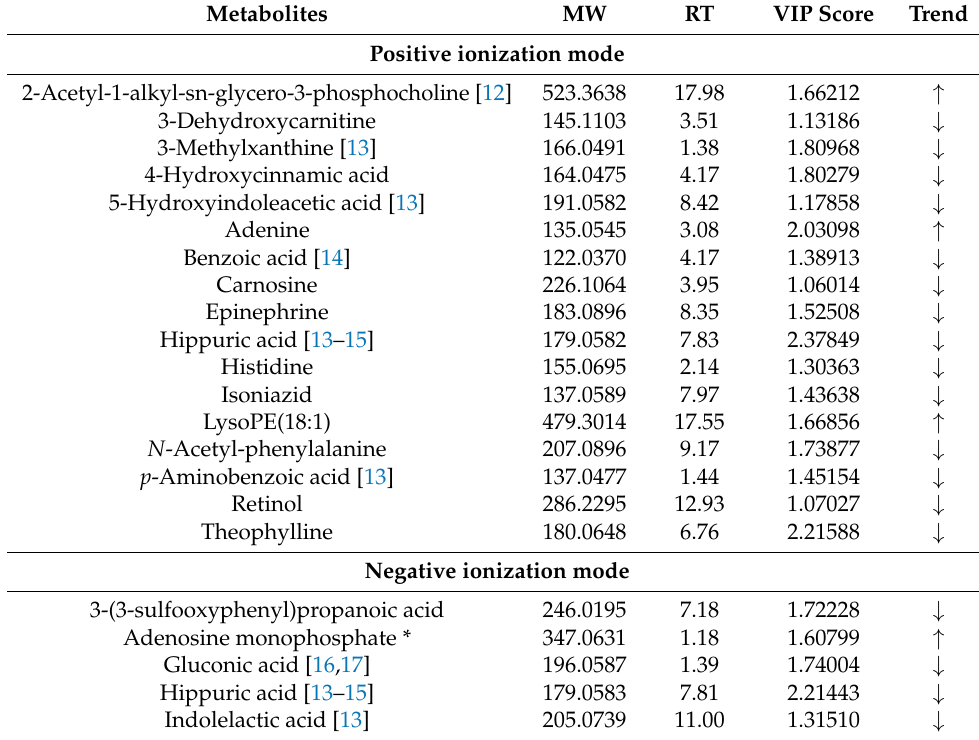
Table 2. Differential metabolites in positive and negative ionization mode. References indicate BC’s previous clinical studies in which the metabolite was selected as discriminant and/or dysregulated (MW—molecular weight; ↓ indicates down-regulation and ↑ indicates up-regulation in BC).